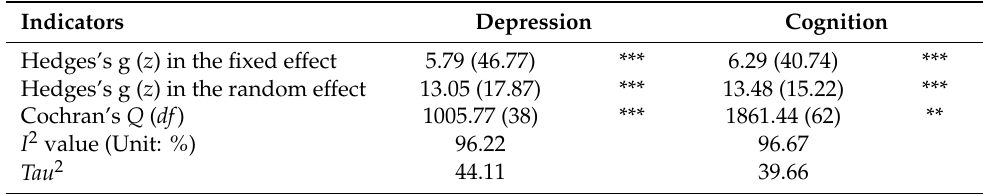
Table 2. Heterogeneity of the examined intervention programs. Indicators